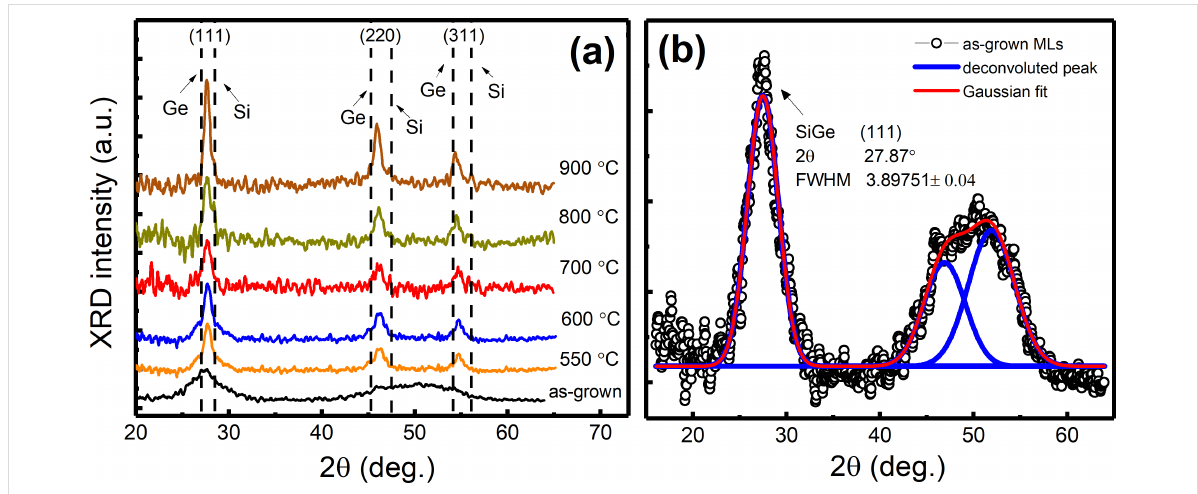
Figure 1: (a) GiXRD diffractograms of MLs annealed from 550–900 °C along with the as-grown MLs. The SiGe crystallographic peaks (111), (220) and (311) are positioned between the tabulated peaks of Si and Ge presented by the dotted lines (for cubic Ge (2 θ = 27.45°, 45.59° and 54.04°; ASTM 01-079-0001) and cubic Si (28.45°, 47.31° and 56.13°; ASTM 01-070-5680)). (b) Deconvoluted GIXRD diffractogram for SiO 2 /SiGe/SiO 2 MLs, as-deposited (black circles) with the Gaussian fits shown by the red line.